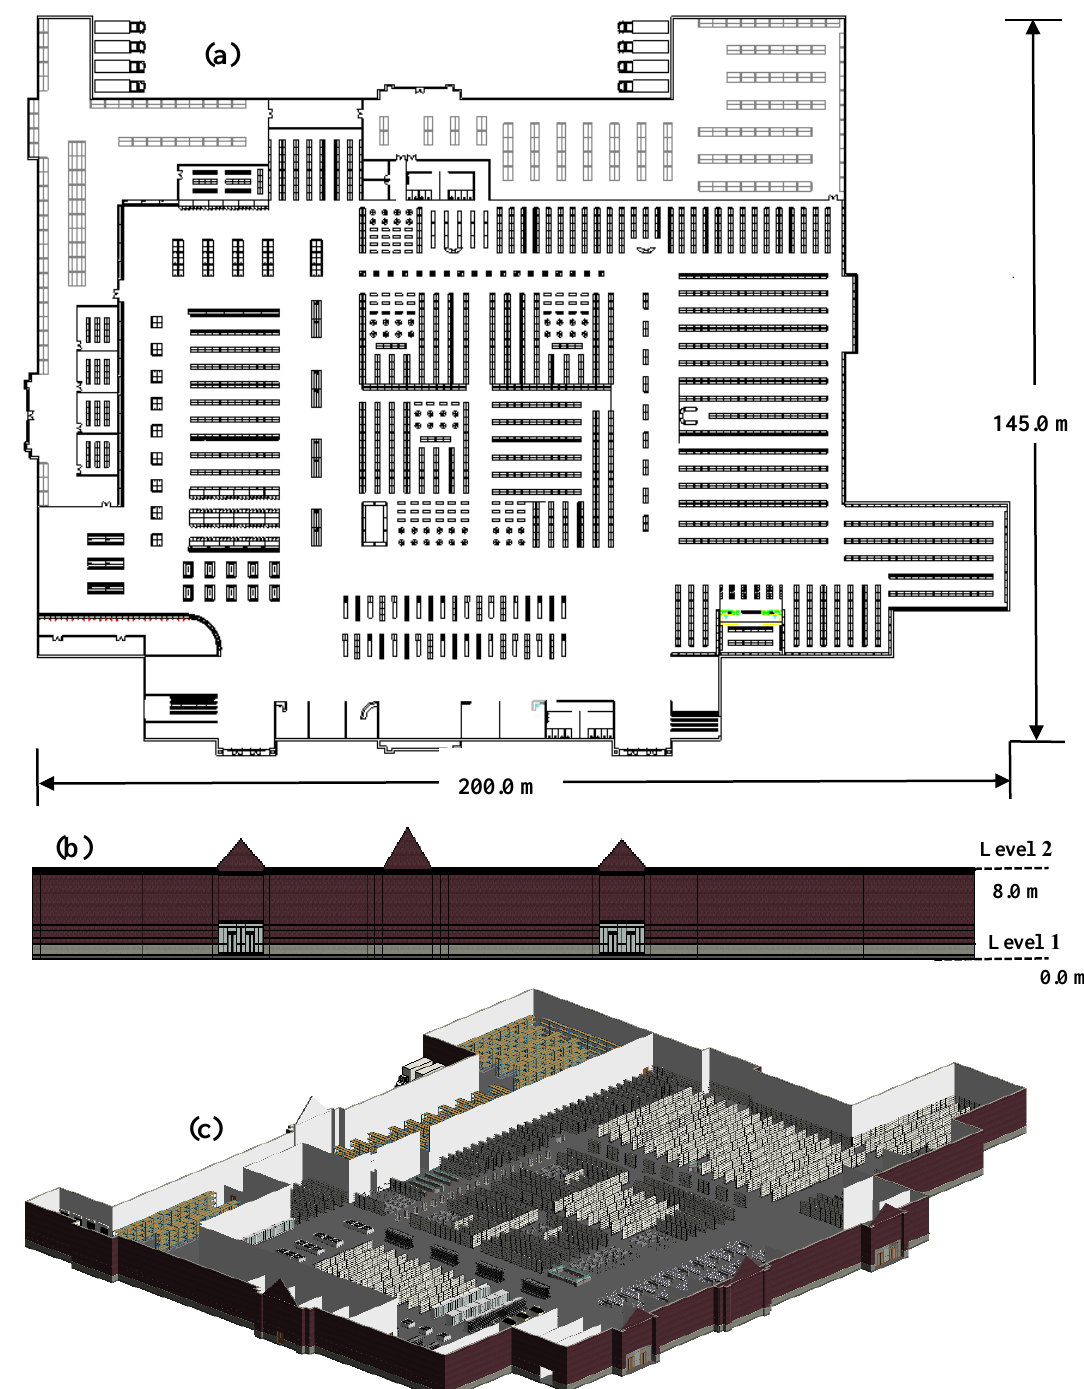
Figure A8. F8 archetype plans and sections: ( a ) Plan view; ( b ) Side view for the store; ( c ) 3-D view for the whole Market.